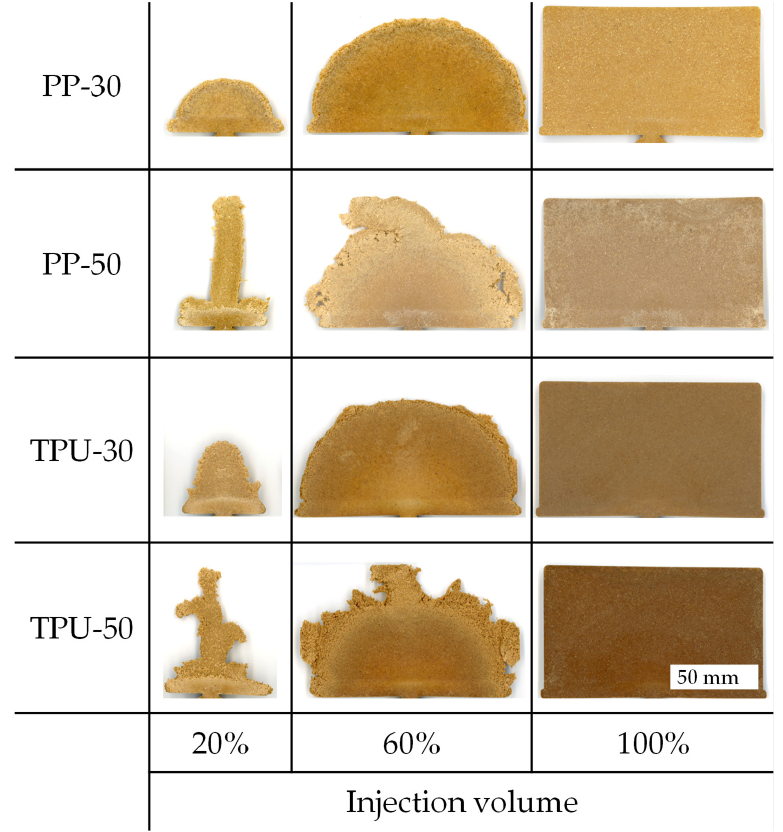
Figure 3. Filling studies (20, 60, 100% injection volume) depending on the matrix material (TPU, PP) and the wood content (30, 50 wt.%).